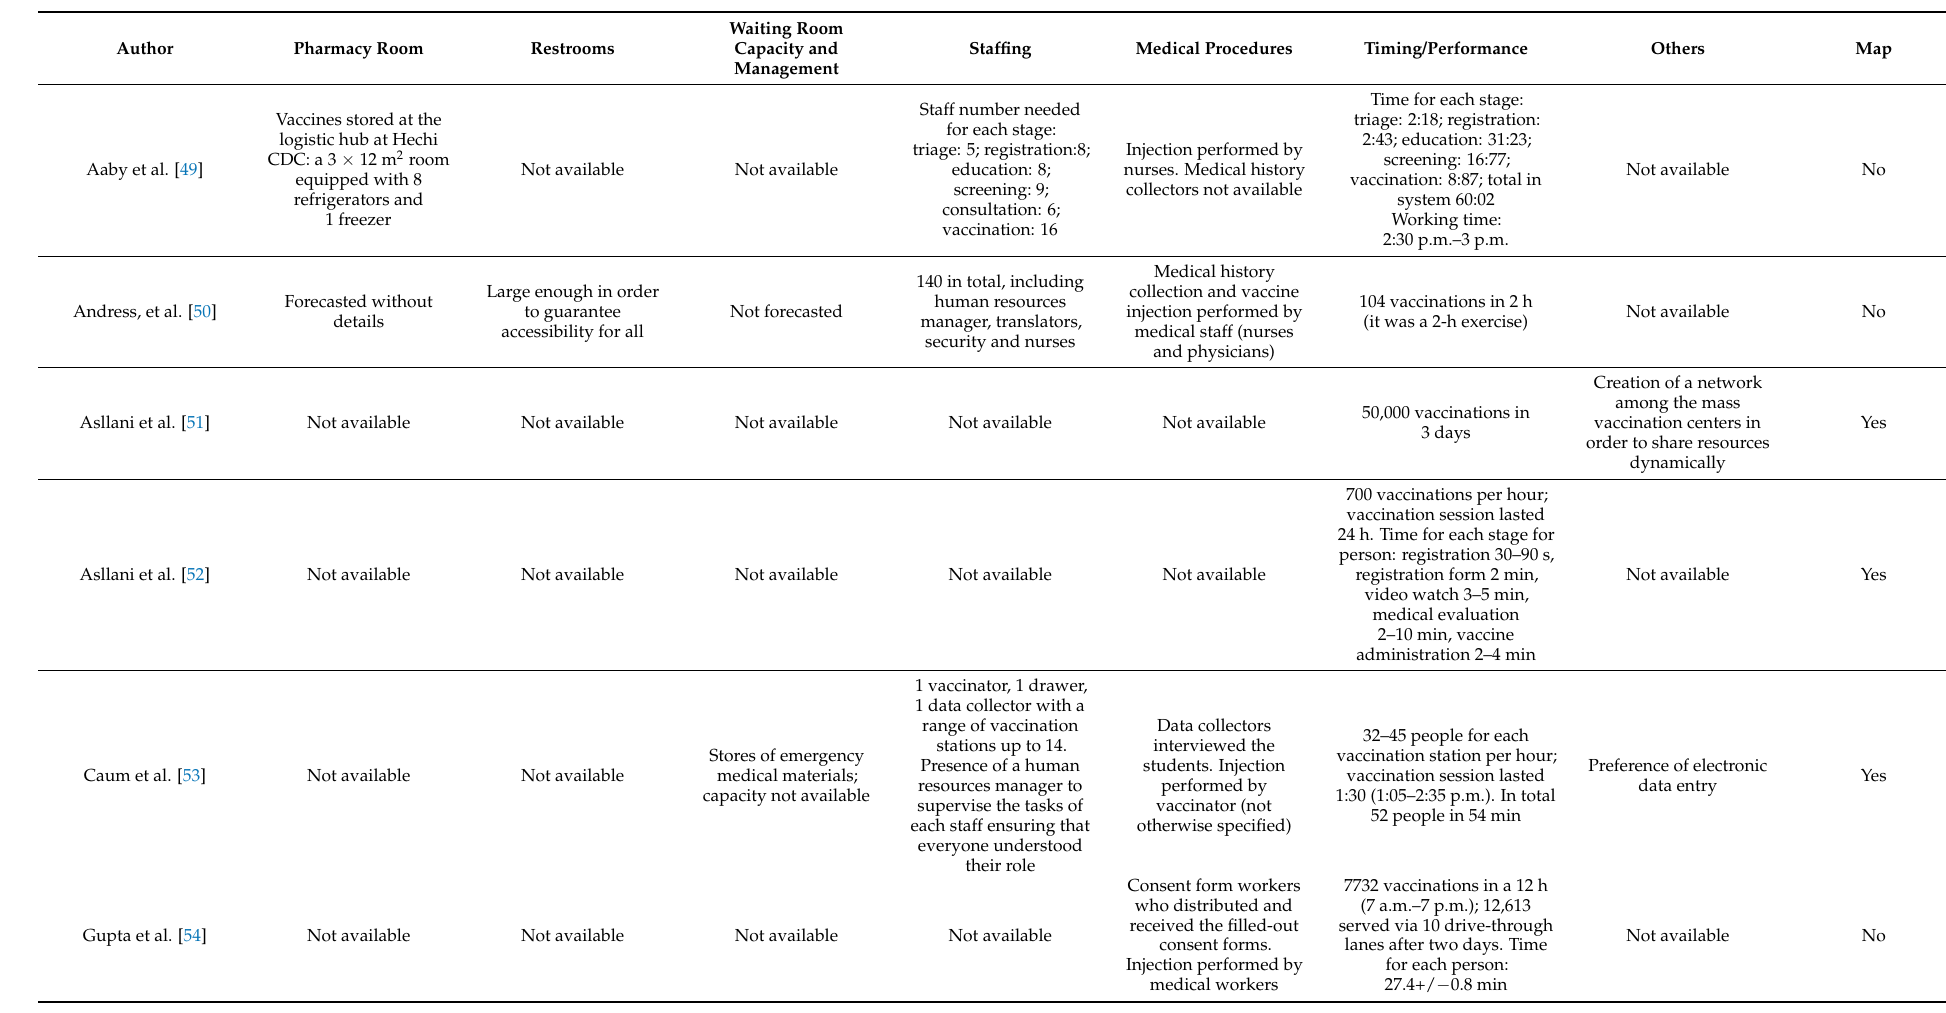
Table 2. Detailed description of the rooms, role and performance of the mass vaccination centers presented in the included